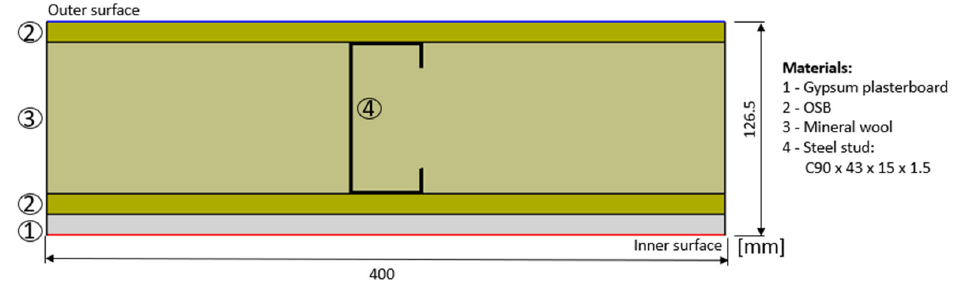
Figure 1. Reference load-bearing partition LSF wall: horizontal cross-section.